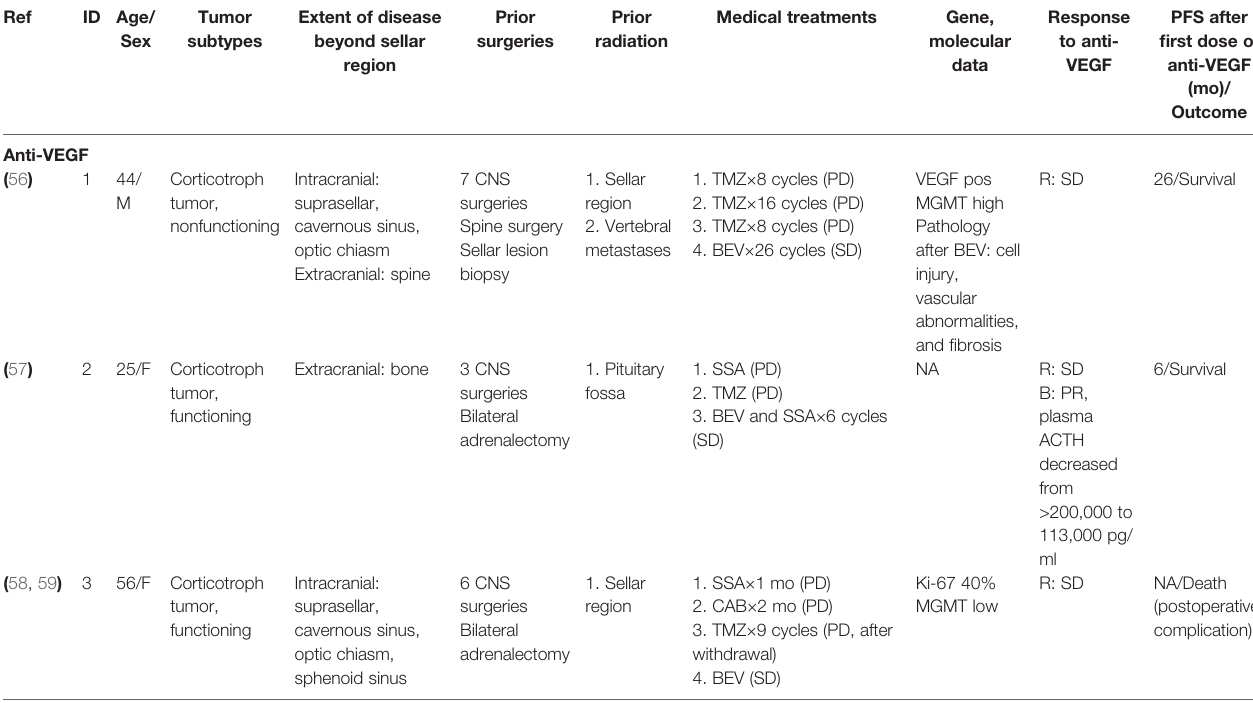
TABLE 2 | Cases of pituitary carcinomas and aggressive pituitary tumors treated with